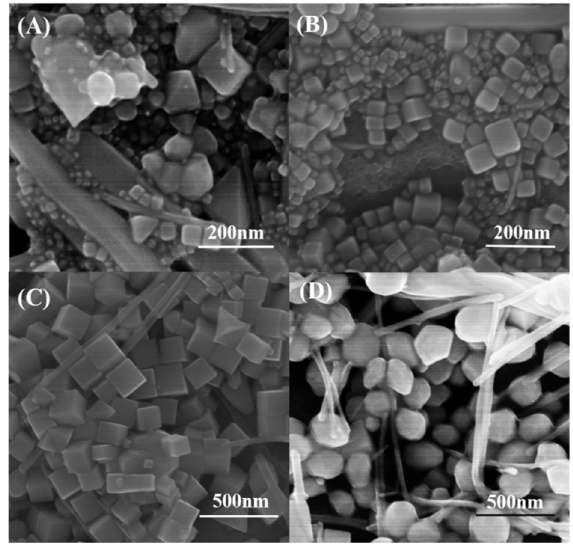
Figure 3. SEM images of the samples obtained at various reaction times for a standard Pd nanocubes synthesis: ( A ) 4.0, ( B ) 5.0, ( C ) 9.0, and ( D ) 15 h, respectively.